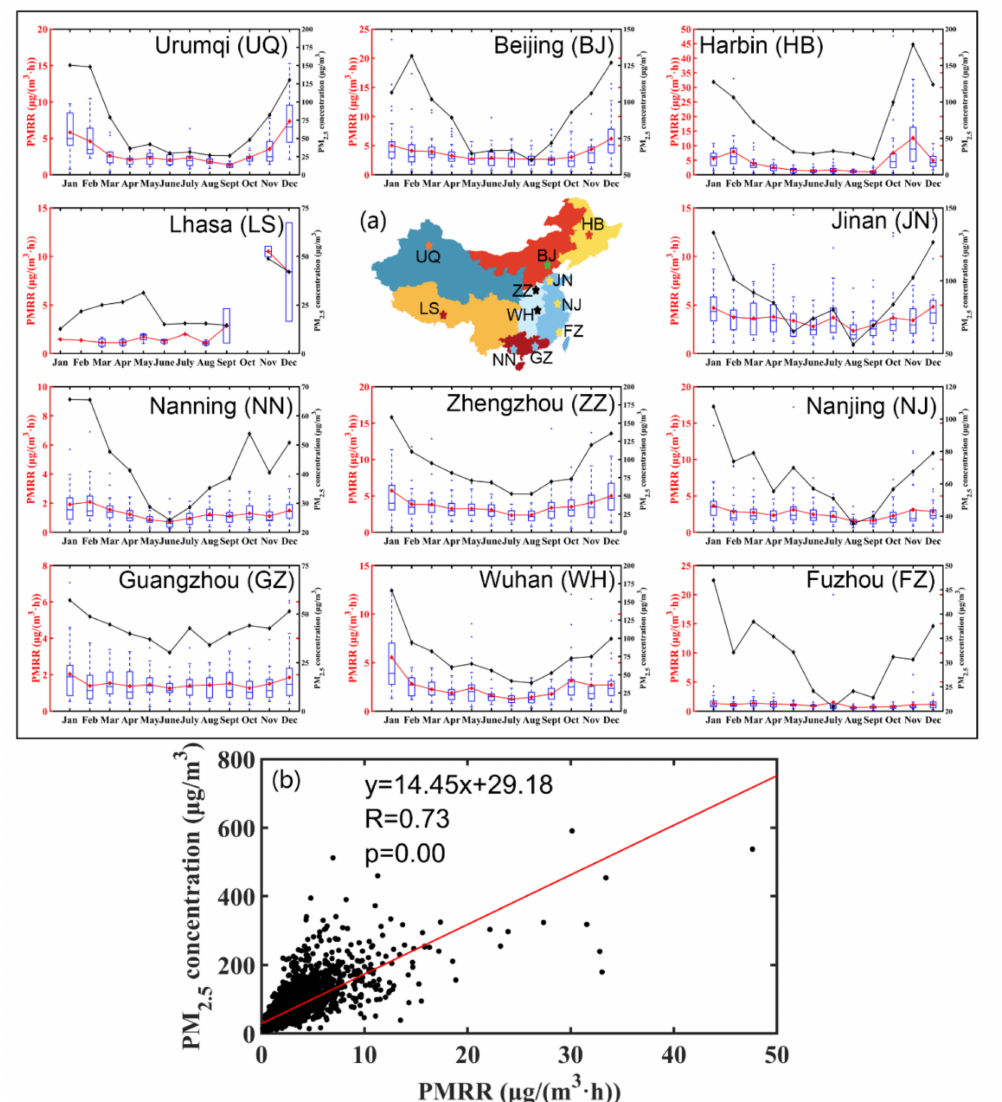
Figure 9. ( a ) The boxplots of the rising rate of PM 2.5 concentration (PMRR) (blue boxes), monthly average PMRR (red lines), and monthly average PM 2.5 concentration during the pollution processes (black lines) in the 11 cities, and ( b ) the relationship between PMRR and PM 2.5